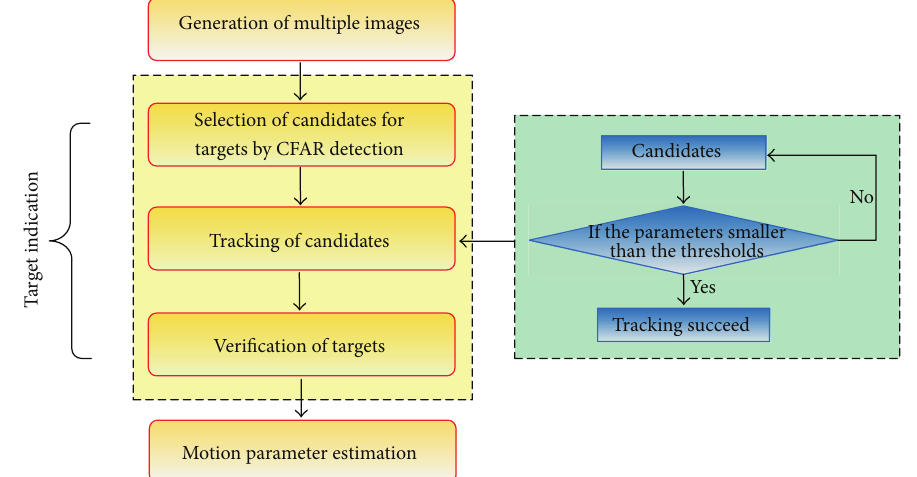
Figure 8: The procedure of maritime monitoring.